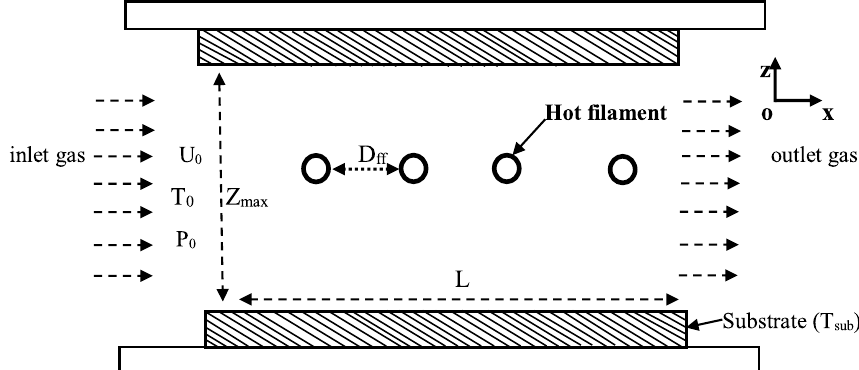
Table 1 Values of parameters used for the reactor Parameter Typical values Filament temperature (K) 2100 Substrate temperature (K) 1173 Initial temperature of gas (K) 300 Pressure (Pa) 1000 Inlet velocity (mm s − 1 ) 10 Length of the reactor in the x direction (mm) 240 Distance between substrates (mm) 20 Distance between three filaments (mm) 50 Distance between four filaments (mm) 33.3 Inlet gas composition CH 4 /H 2